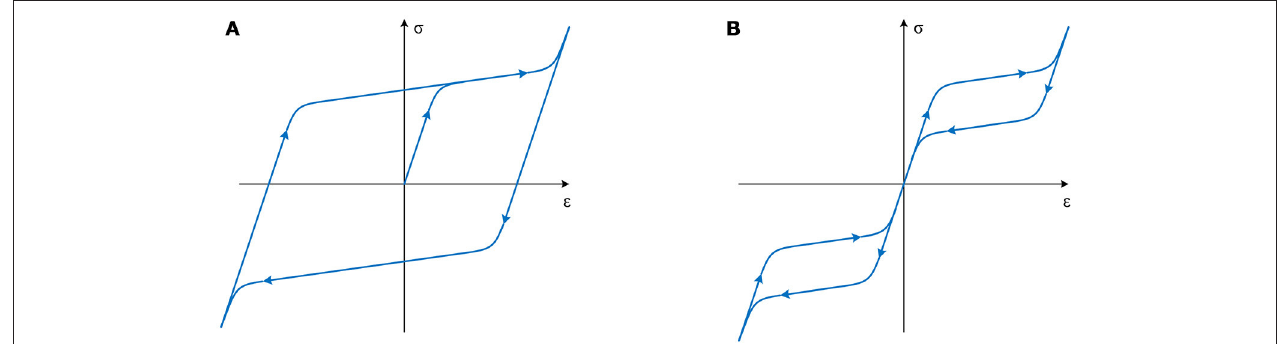
FIGURE 1 | Schematic representation SMA behavior (A) twinning hysteresis ( T < M f ), (B) superelasticity ( T > A f